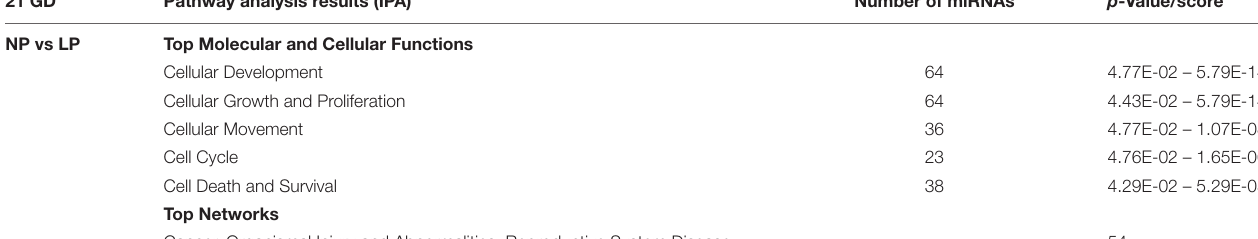
TABLE 4 | Top canonical pathways affected by differentially expressed miRNAs in 21 DG and 7 DL metanephros. 21 GD Pathway analysis results (IPA) Number of miRNAs p